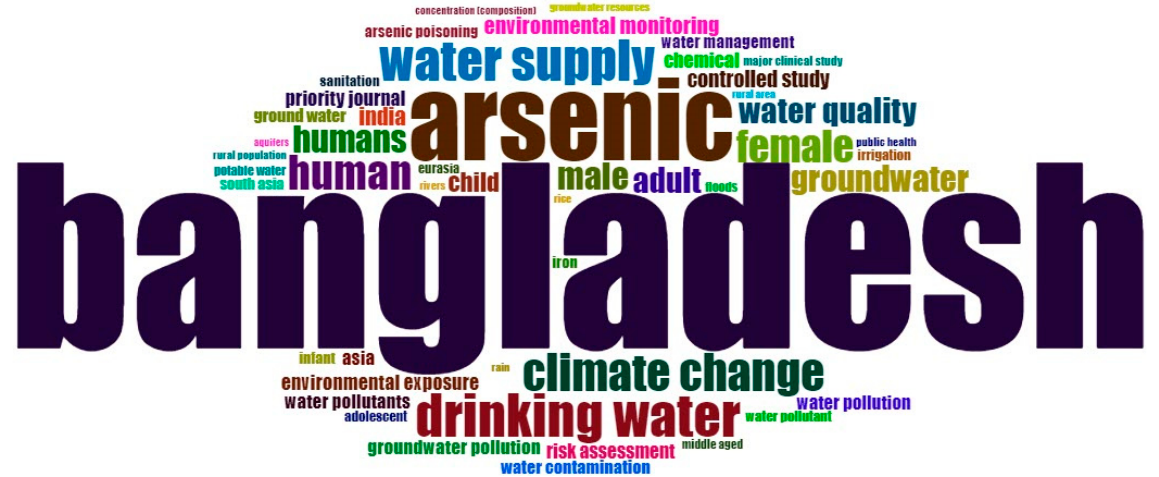
Figure 4. Word cloud in terms of keywords plus on Bangladesh water-research-related publications .